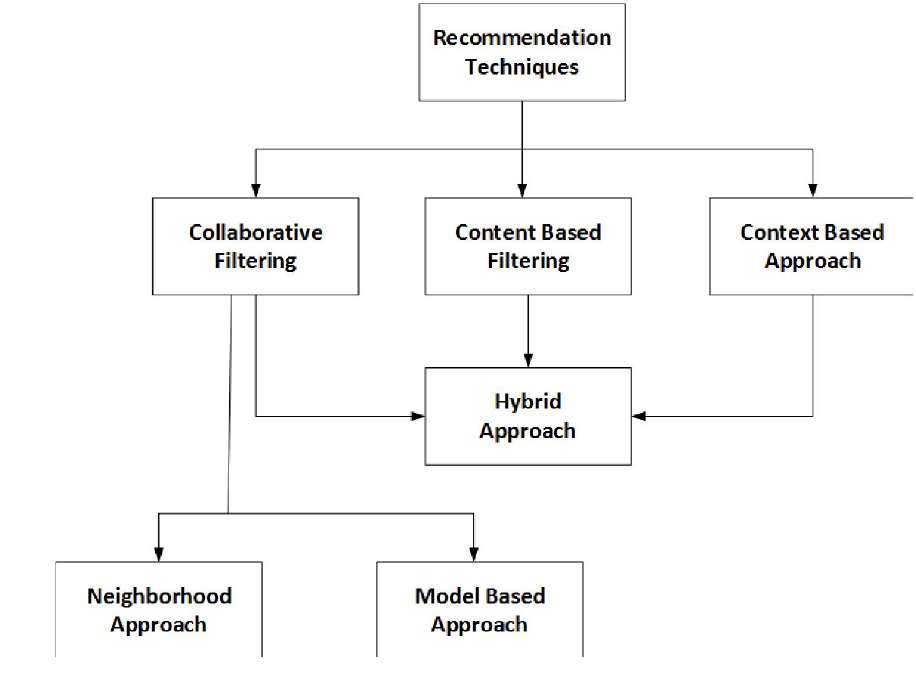
FIG. 1. TECHNIQUES FOR RECOMMENDER